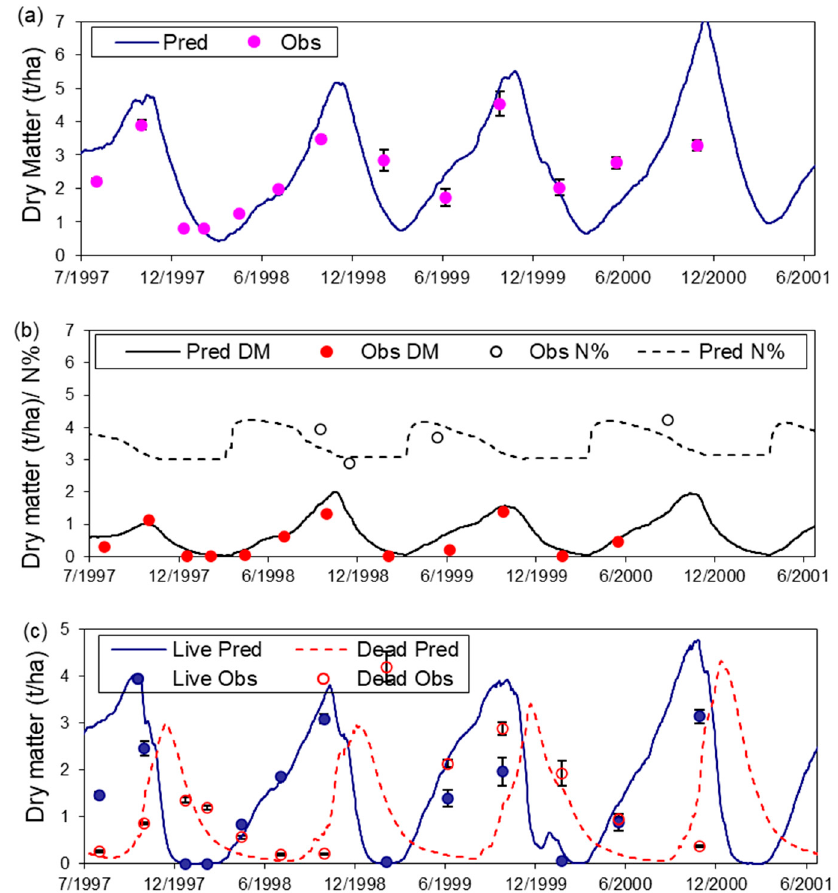
Figure 6. Observed and predicted ( a ) sward total pasture dry matter (DM) ( b ) clover total dry matter (segmented line and open circles) and N% (solid line and solid circles) and ( c ) live (solid) and dead (segmented) dry matter for the MM system (Points indicate the mean of the observed data; whiskers indicate the standard error of the mean.